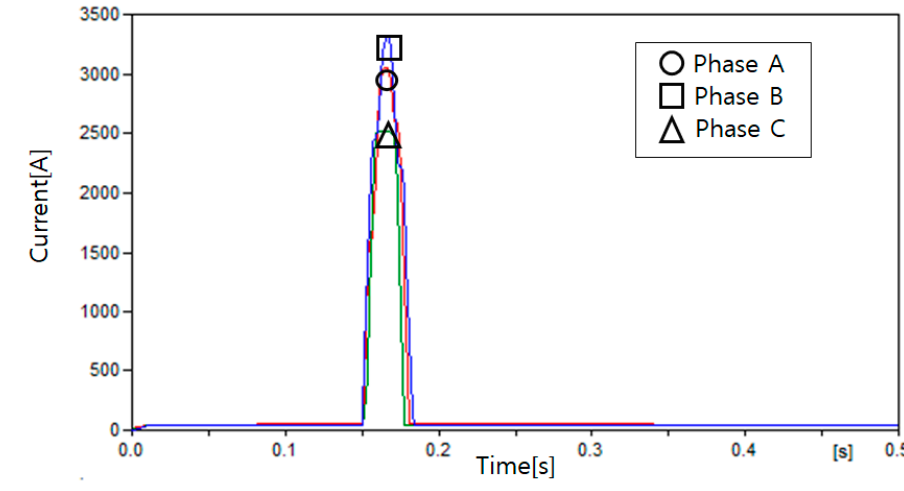
Figure 26. Current measured at I 1 in Case 7.